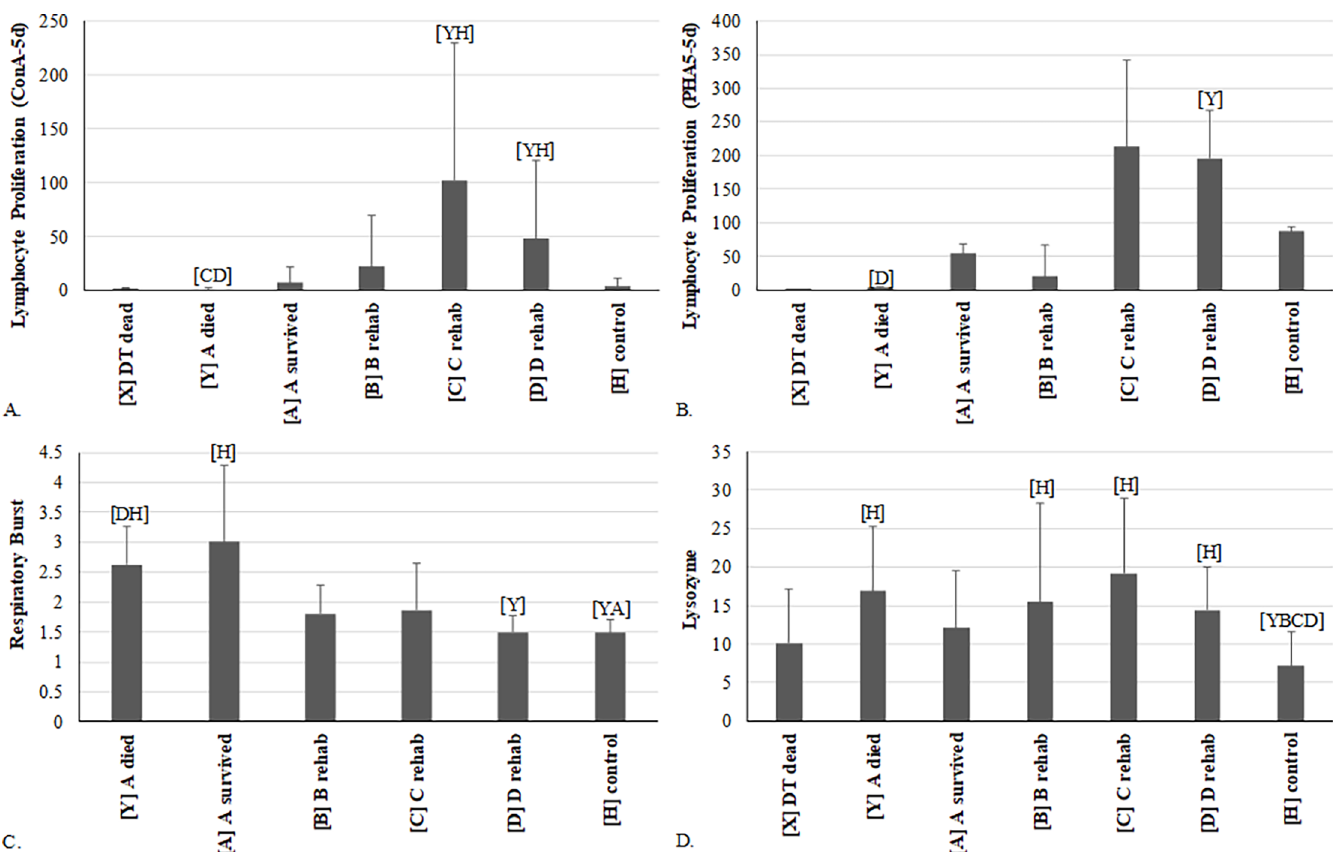
Fig 5. Comparison of immune function variables measured in debilitated loggerhead sea turtles (DTs) before and during rehabilitation and compared to healthy loggerhead turtles (means and one standard deviation). Each turtle group on the x-axis was significantly different (p < 0.05 or p < 0.00883 for repeated measures) from groups represented by letters above data. (A) lymphocyte proliferation with ConA; (B) lymphocyte proliferation with PHA; (C) respiratory burst with Ca ionophore; and (D) lysozyme activity. Lines represent an individual turtle through rehabilitation. For samples sizes in each diagram, please refer to S4